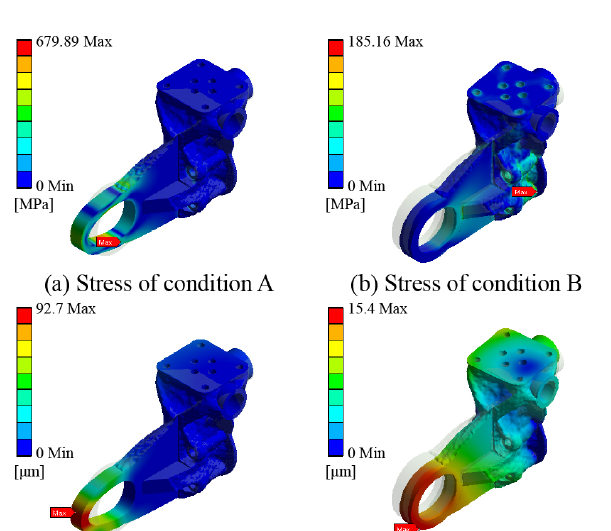
Figure 12. Stress and deformation of the push